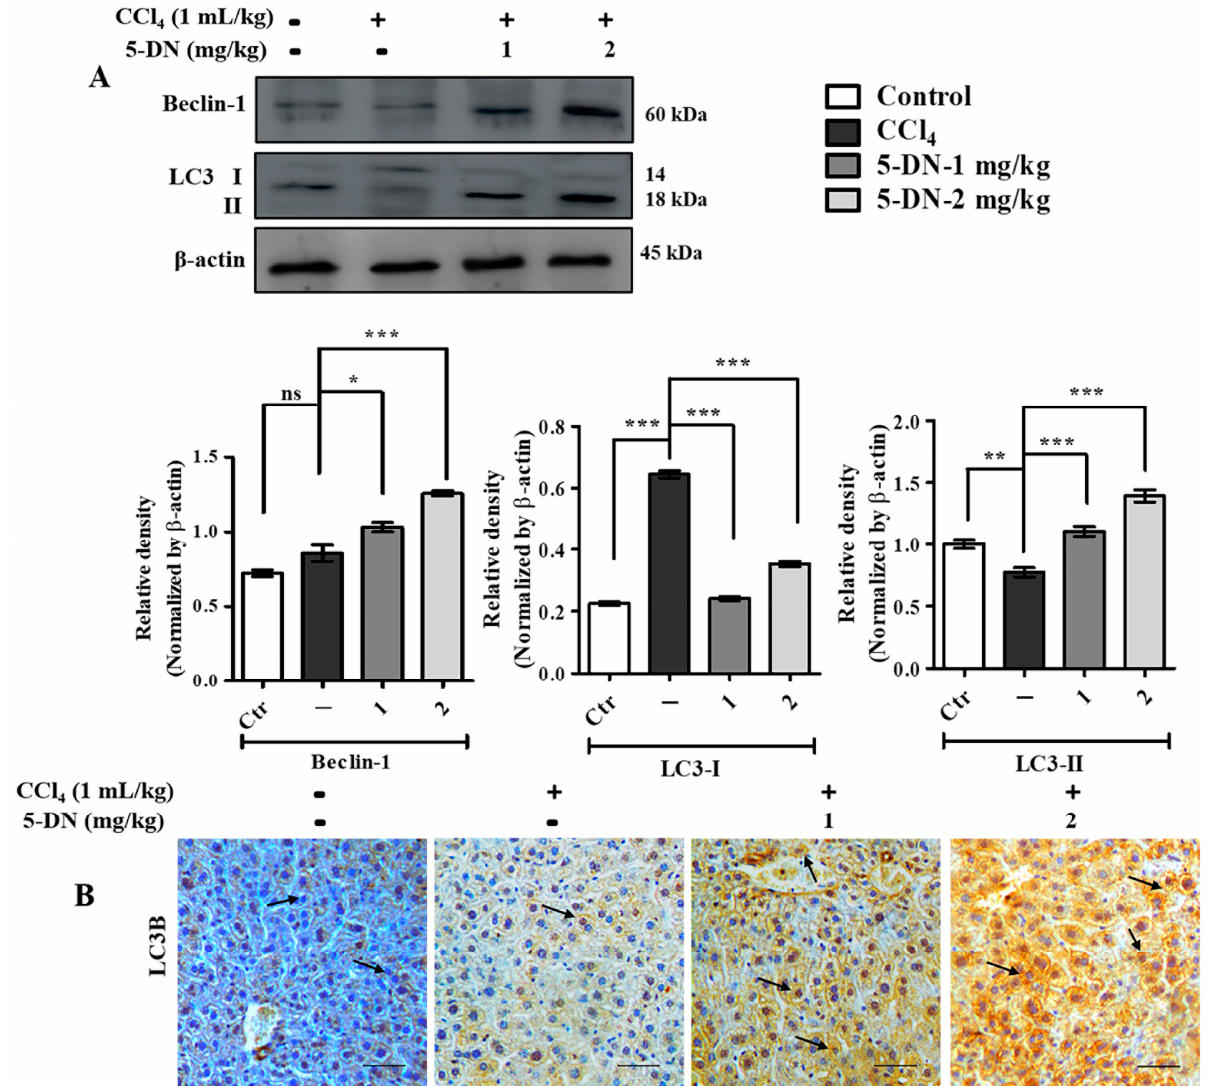
Figure 7. 5-DN promoted autophagosome formation in CCl4-treated BALB/c mice (mice, n = 6/group). (A) Western blot-ting analysis of important autophagy markers and their quantification. (B) Immunohistochemical staining of LC3B from BALB/c liver tissue Arrow ( → ): indicates the formation of punctate structure in liver tissue. (Magnification: 200 × , Scale bar (100 µ M). Images were captured using an Olympus BX51 fluorescence microscope. Densitometry analysis of these respective proteins were normalized by β -actin and evaluated through Image J software. The data are represented as mean ± S.D. of three independent experiments * p < 0.05, ** p < 0.01, *** p < 0.001 and ns (non-significant). Control vs. CCl4, CCl4 vs. 5–DN (1–2 mg/kg). Statistical significance analysis was carried out through one-way analysis of variance (ANOVA)